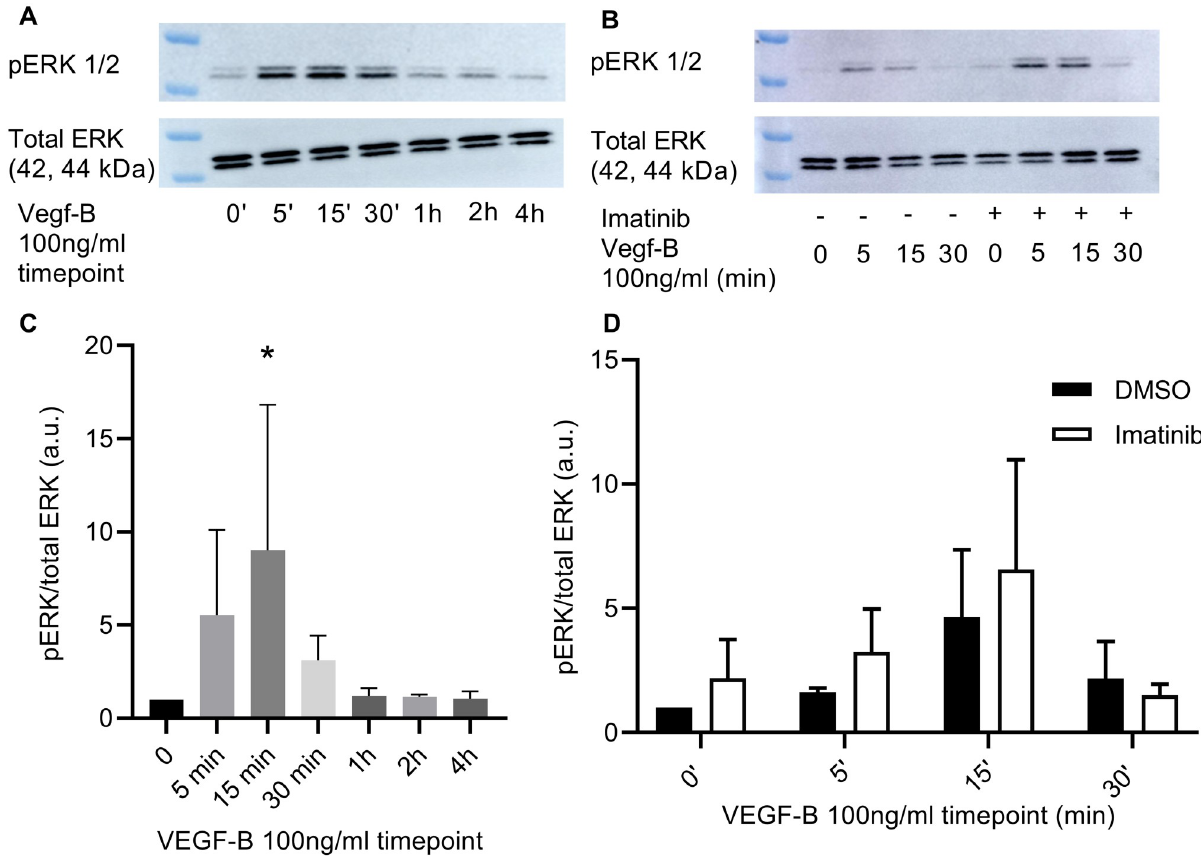
Fig 5. Effect of vascular endothelial growth factor-B (VEGF-B) and imatinib on ERK1/2 phosphorylation. A: Western blot images of VEGF-B mediated phosphorylation of ERK1/2 at different time points. C: Quantification of A. The treatment of HUVECS with VEGF-B enhanced the phosphorylation of ERK1/2 at 15 min stimulation with VEGF-B. � P = 0.04 in Bonferroni post hoc test of repeated measures one-way ANOVA. B: Western blot images of the effect of imatinib on VEGF-B mediated ERK1/2 phosphorylation (“-” = DMSO; “+” = Imatinib). D: Quantification of B. Imatinib caused no effect on the phosphorylation of ERK1/2 in basal conditions and in conditions treated with VEGF-B. � P < 0.05 in Bonferroni post hoc test of repeated measures two-way ANOVA. a.u. = arbitrary units; n = 3. For uncropped blot images see S1 Fig.